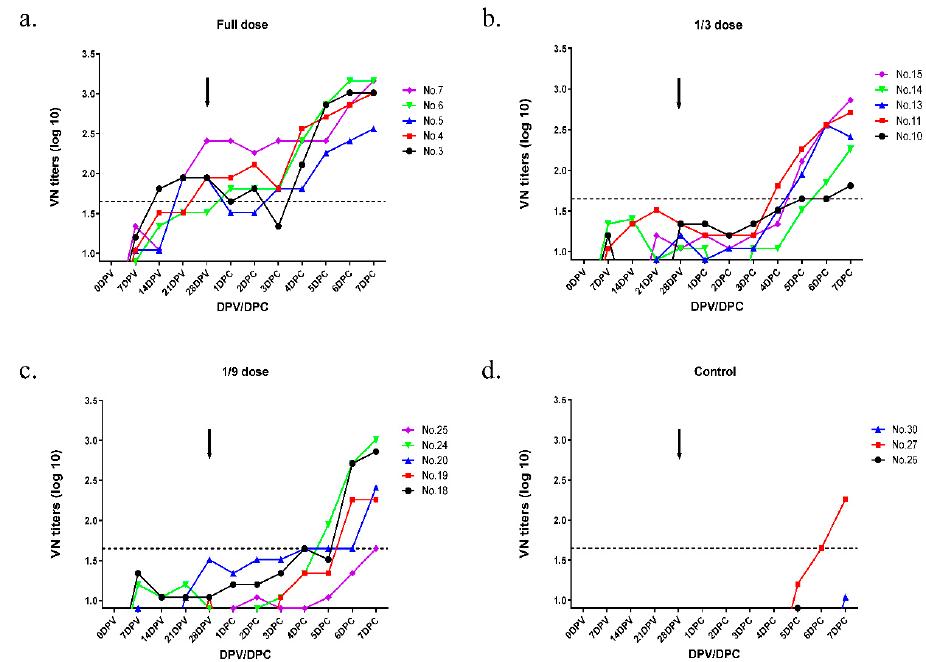
Figure 4. Virus neutralizing antibody titers against serotype O homologous virus in pigs after immunization with the bivalent vaccine. Pigs ( n = 18) were divided into four groups (full dose, 1/3 dose, 1/9 dose, control) and blood samples were collected at 0, 7, 14, 21, and 28 days post-vaccination. Pigs were challenged with O/Boeun/SKR/2017 at 28 dpv with 1 × 10 5 TCID 50 /0.1 mL in the bulb of the heel. Blood samples were collected until 7 days post-challenge. Virus neutralization test with O/Boeun/SKR/2017 was performed using the sera collected from vaccinated pigs (five heads per group) with full dose ( a ), 1/3 dose ( b ), and 1/9 dose ( c ). VN titers of the sera were collected from three heads of non-vaccinated pigs as the control ( d ). Black arrows indicate the challenge time at 28 dpv. Table 1. Summary of the immune response and protective effect for O/Boeun/SKR/2017 after immunization of pigs with the bivalent vaccine. Virus Neutralizing Antibody Titers (log 10 ) Groups